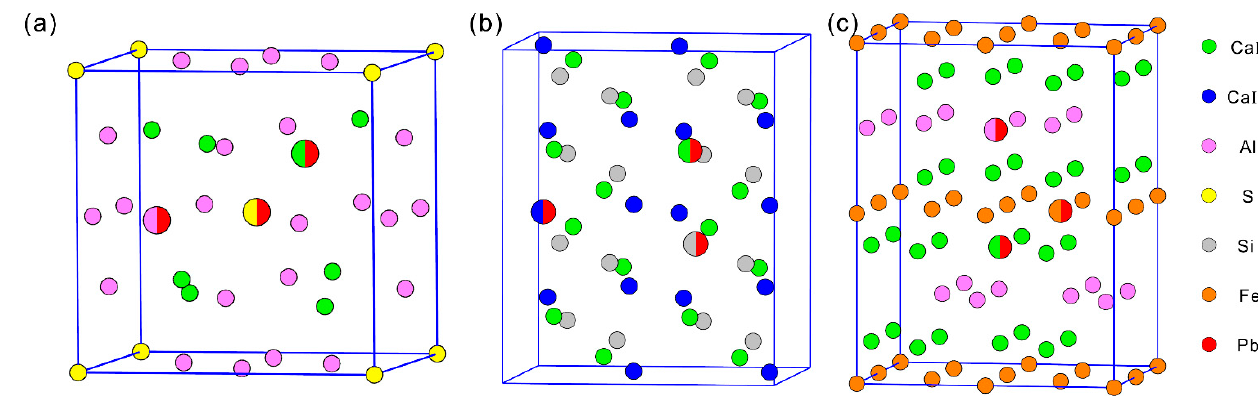
Figure 1. Schematic structures of SAC clinker phases: ( a ) C 4 A 3 S(cid:3364) , ( b ) C 2 S, and ( c ) C 4 AF. The doping sites are highlighted with bigger bicolored balls in each panel. One color (the red one) represents Pb and the other one stands for the atoms been substituted. The green, blue, purple, yellow, grey, orange, and red balls represent six-fold Ca, eight-fold Ca, Al, S, Si, Fe, and Pb, respectively.